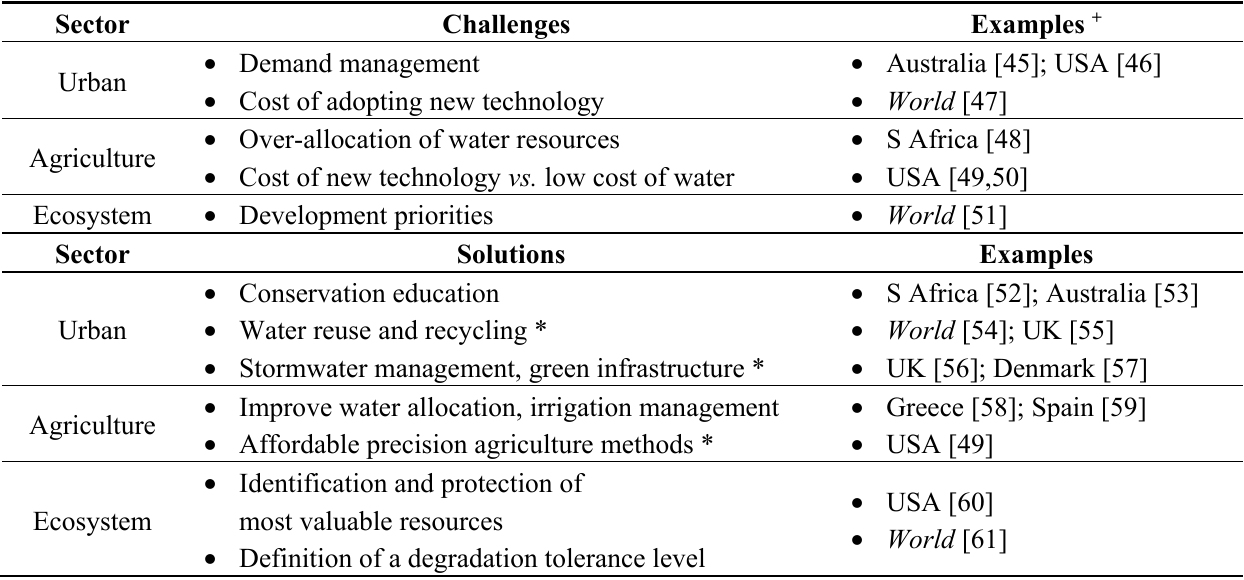
Table 4. Developed country challenges and solutions for sustainable water management in urban, agricultural, and natural